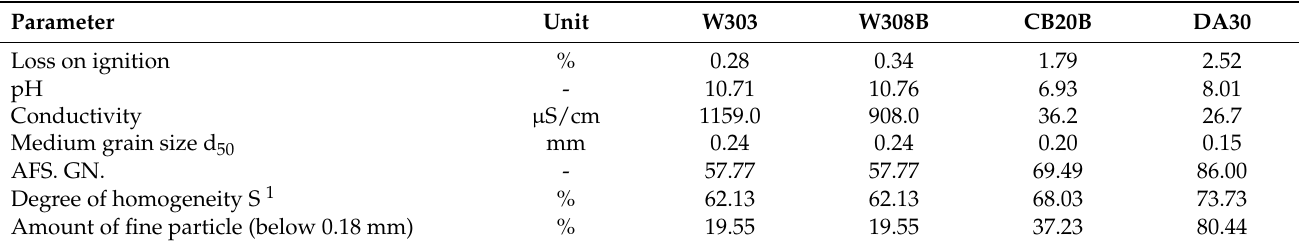
Table 2. General parameters of studied core